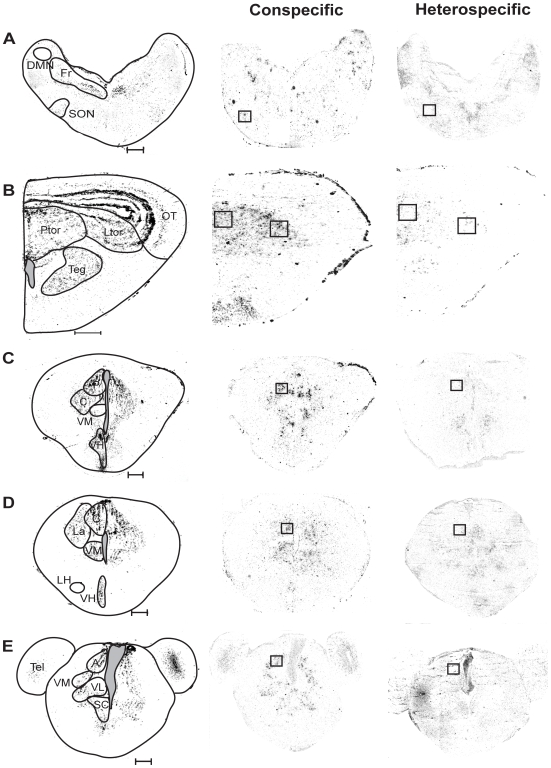
Brightfield images (left column) and inverted darkfield images of transverse sections showing egr-1 expression within sampling windows (boxes) in response to conspecific whine-chucks (middle column) and heterospecific whines (right column) in the auditory brainstem (A–B) and thalamus (C–E).Scale bars represent 400 µm. Abbreviations: A, anterior thalamus; C, central thalamus; DMN, dorsal medullary nucleus; Fr, reticular formation; La, lateral thalamus; LH, lateral hypothalamus; Ltor, laminar nucleus of the torus semicircularis; OT, optic tectum; P, posterior thalamus; Ptor, principal nucleus of the torus semicircularis; SC, suprachiasmatic nucleus; SON, superior olivary nucleus; Teg, tegmentum; Tel, telencephalon; VH, ventral hypothalamus; VL, ventrolateral thalamus; VM, ventromedial thalamus.